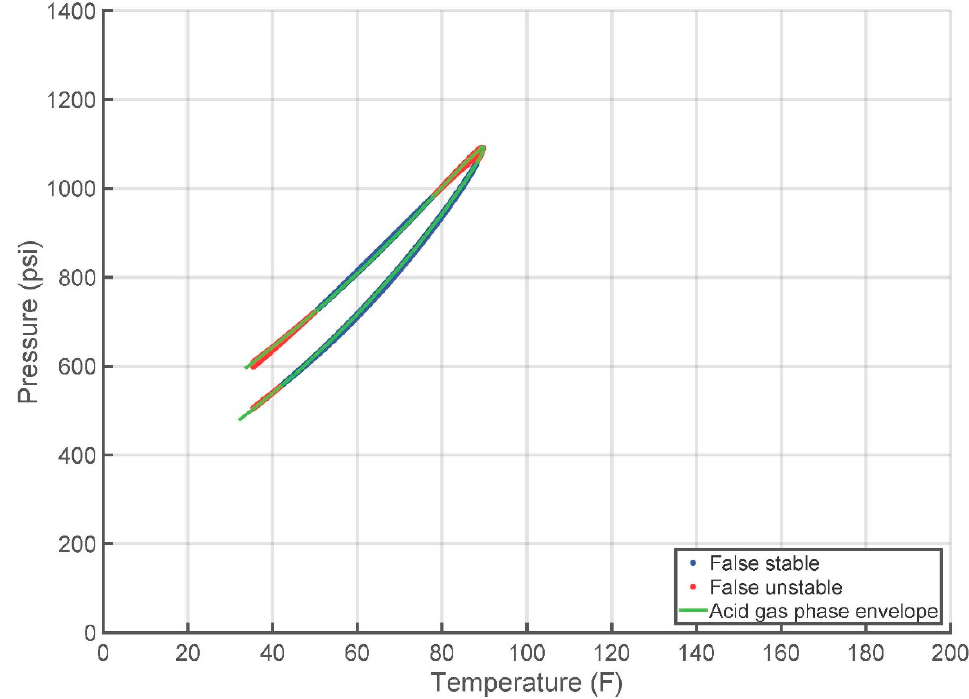
Figure 9. Visualization of the neural network model results on testing datapoints (80% CO 2 ).